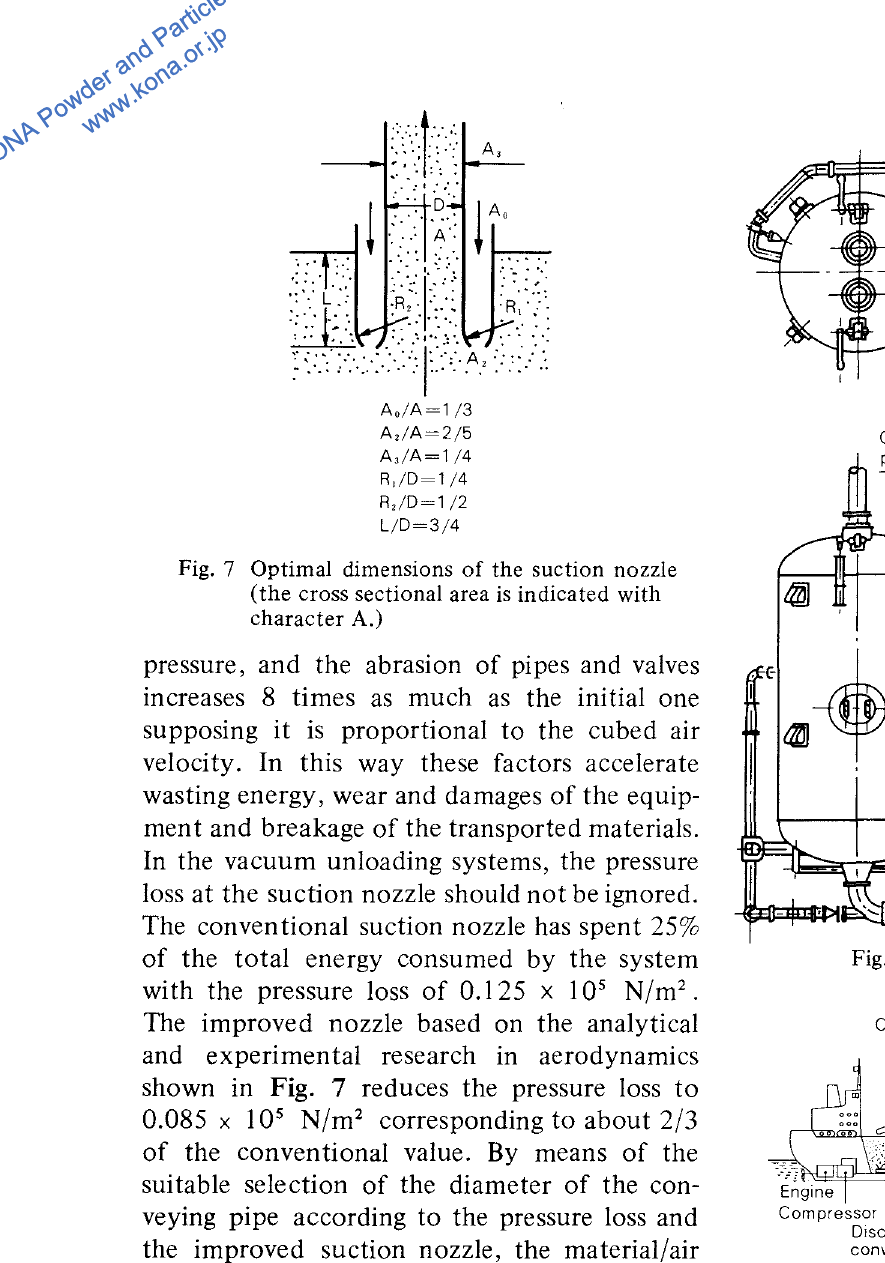
Fig. 9 The schematic diagram of a dual blow tank system on a bulk cargo ship for conveying